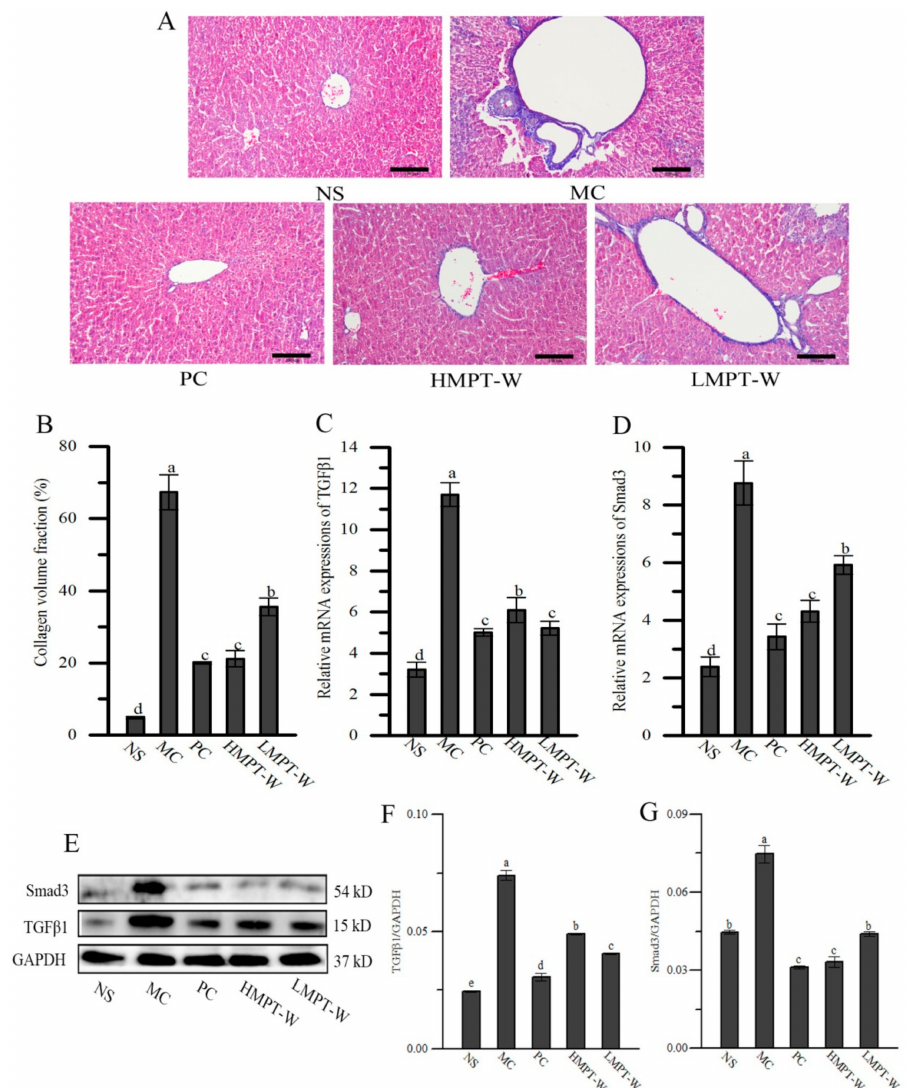
Figure 6. E ff ect of MPT-W on hepatic fibrosis in CCl 4 -induced chronic liver injury mice. ( A ) Masson staining images of liver sections from NS, MC, PC, HMPT-W and LMPT-W treated mice, magnification 200 × ; ( B ) collagen volume fraction; ( C ) TGF β 1 mRNA; ( D ) Smad3 mRNA; ( E ) blotting of TGF β 1 and Smad3; ( F ) TGF β 1 / GAPDH; ( G ) Smad3 / GAPDH. The values are reported as means ± SD. Bars with di ff erent letters (a, b, c, d, e) are significantly di ff erent ( p < 0.05). NS: normal saline, MC: model control, PC: positive control, HMPT-W: 400 mg / kg MPT-W, LMPT-W: 200 mg / kg MPT-W, TGF β 1: transforming growth factor beta 1, Smad3: drosophila mothers against decapentaplegic protein-3, GAPDH: phosphoglyceraldehyde